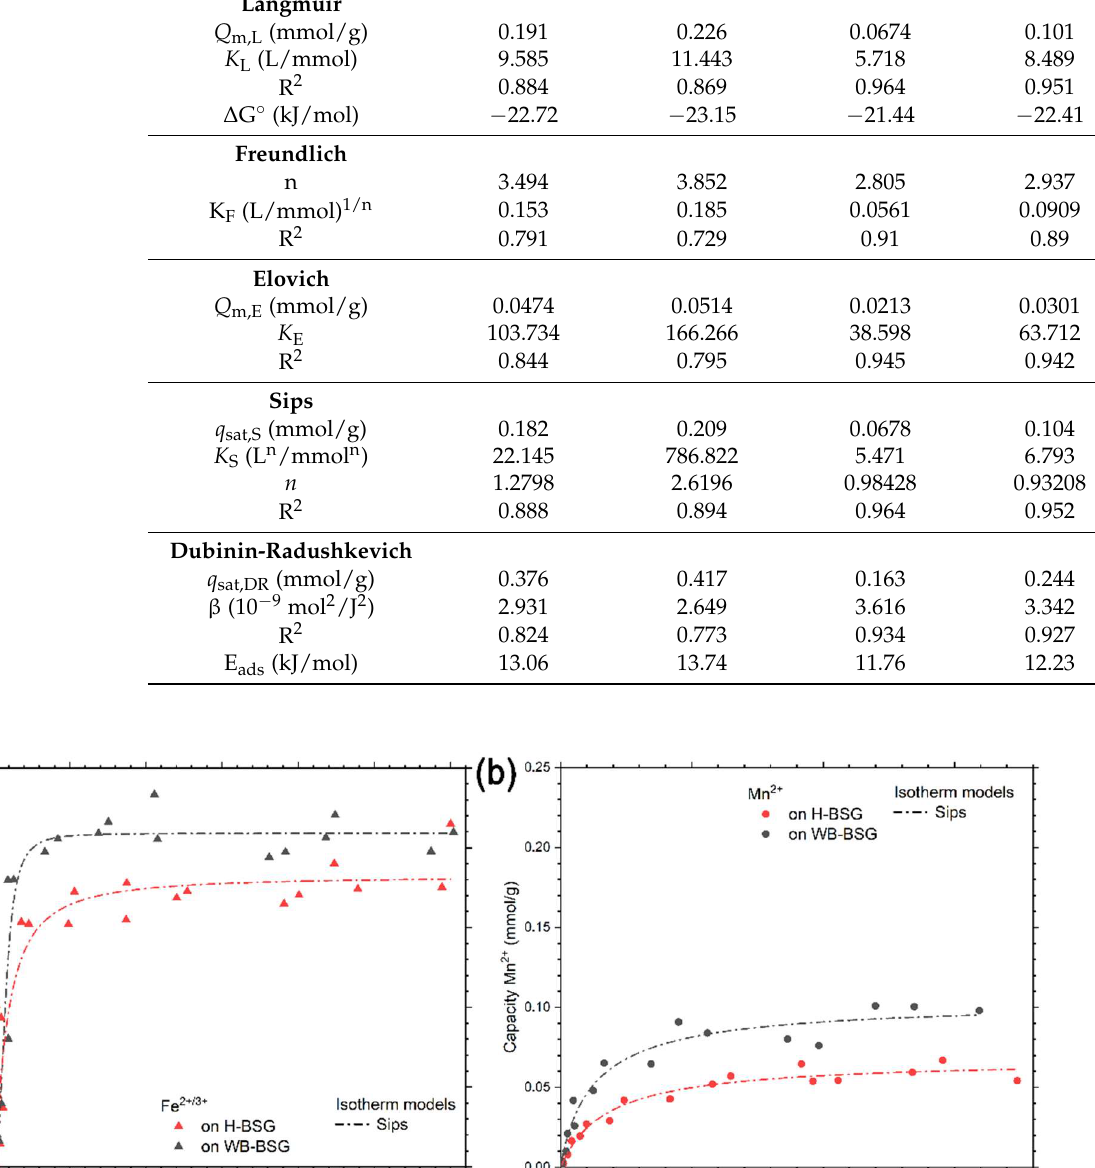
Table 4. Fitting parameters for Fe 2+/3+ and Mn 2+ adsorption onto H-BSG and WB-BSG for Sips, Lang- ments as presented in Figure 8. The graphical fitting comparison is given in Figures S9 and S10.